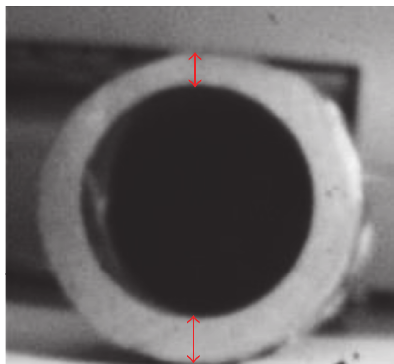
Figure 2: Cross section of a failed boiler tube. Metal loss in fire side of the tube is clear.